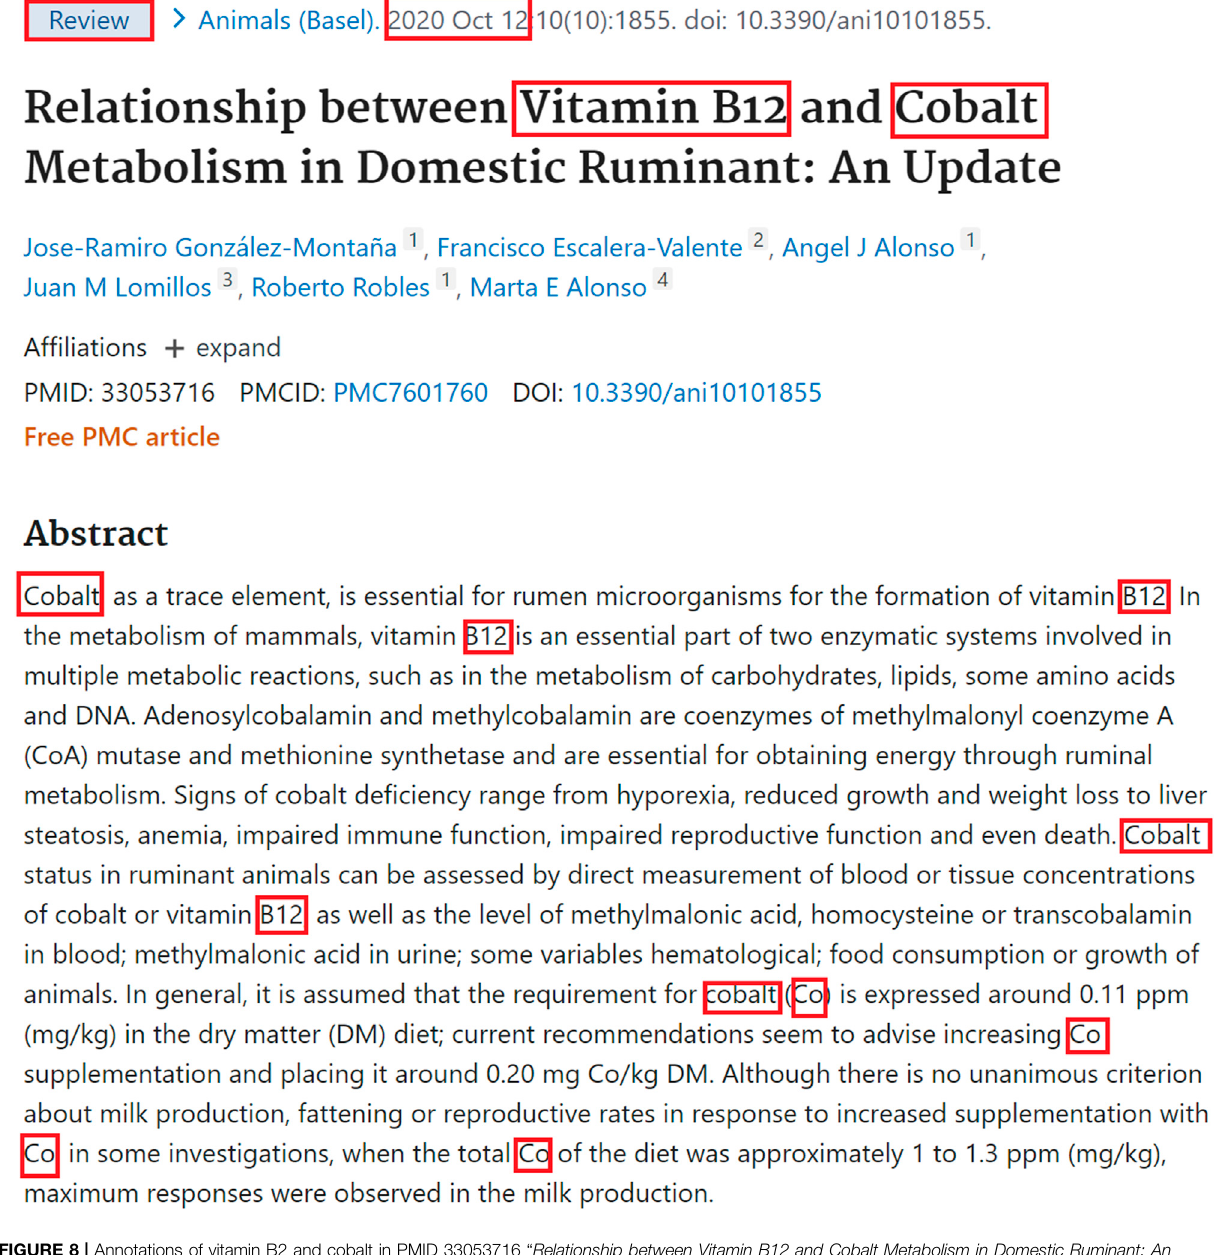
Frontiers in Research Metrics and Analytics |